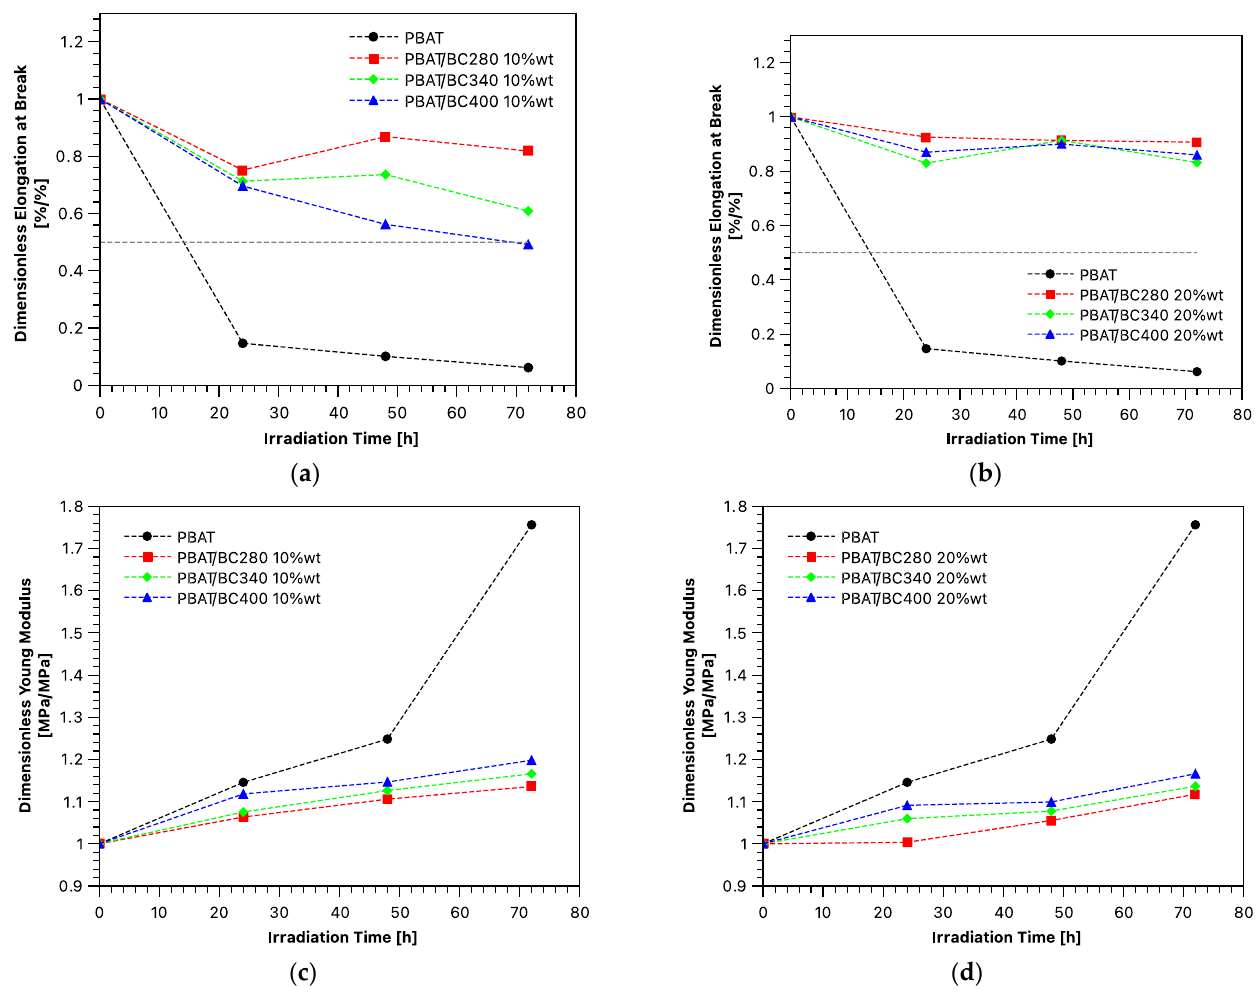
Figure 8. Trends of ( a – b ) dimensionless elongation at break and ( c – d ) dimensionless Young’s Mod- ulus of PBAT/BC biocomposites as a function of UVB exposure time. of PBAT/BC biocomposites as a function of UVB exposure